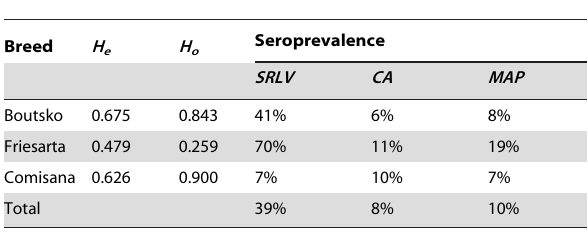
Table 3. Expected ( H e ) and observed ( H o ) heterozygosity for TLR9 gene, in relation to seropositivity for Small